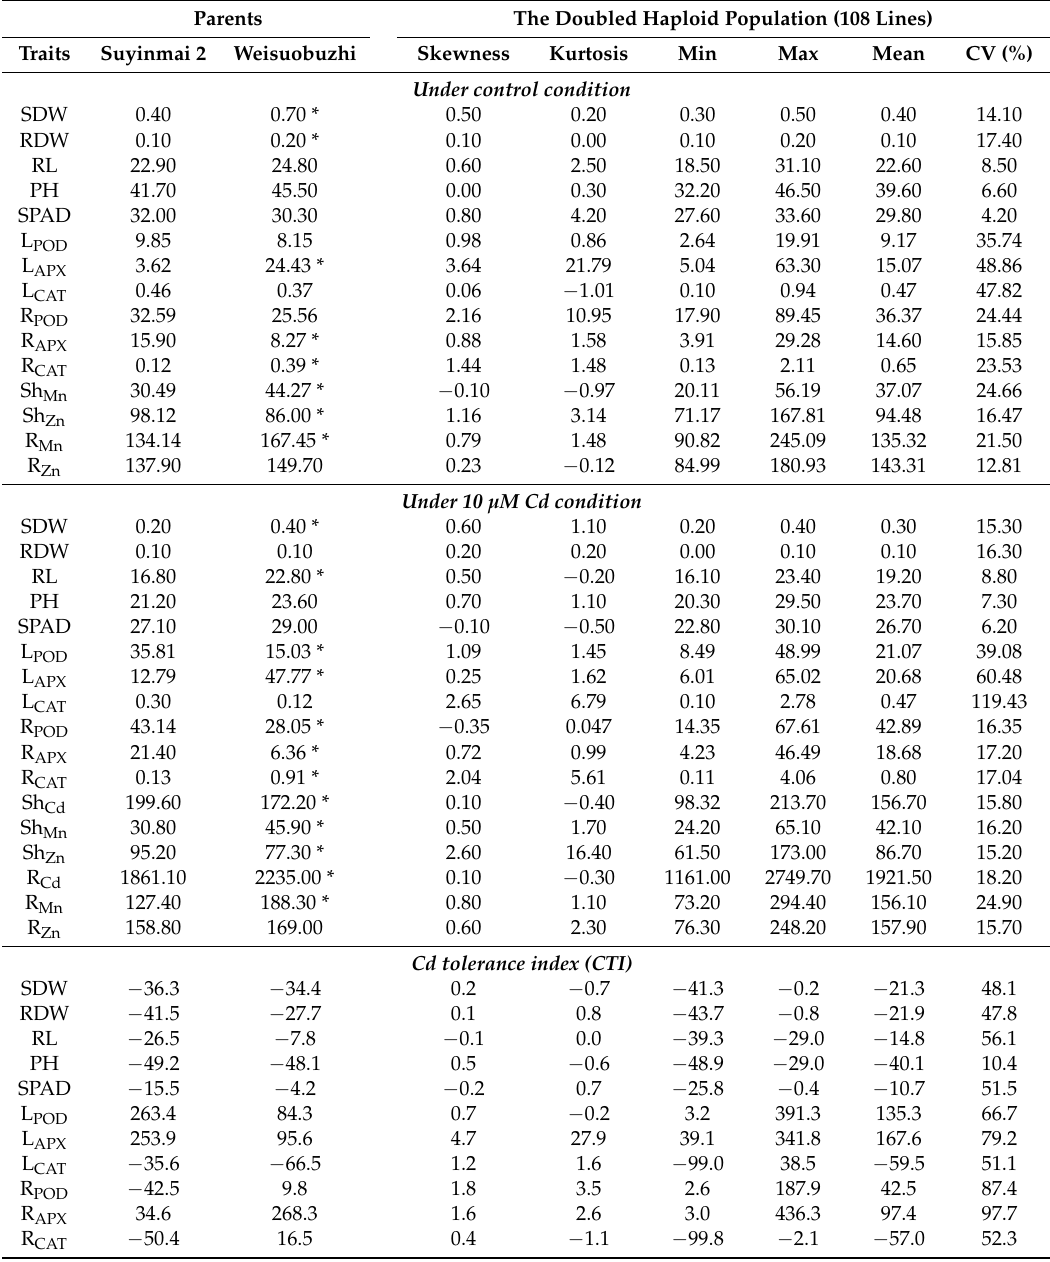
Table 1. Phenotypes of the traits of growth and physiology and Cd tolerance indexes of the doubled haploid population from the cross between Suyinmai 2 and Weisuobuzhi. Parents The Doubled Haploid Population (108 Lines) Traits Suyinmai 2 Weisuobuzhi